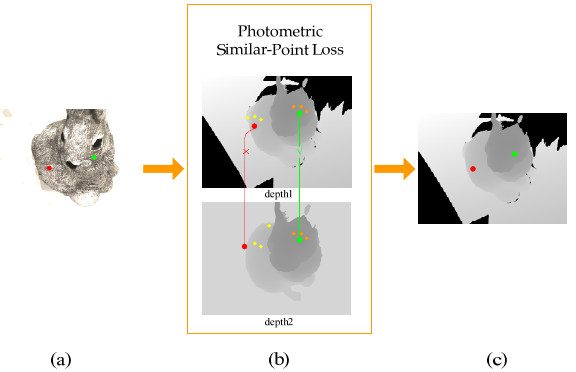
Figure 3. Photometric similar‑point loss: ( a ) a pirate point was selected on the source image; ( b ) the depth map obtained with the network was compared with the depth map constructed using sparse points; ( c ) optimized density depth map. The green line represents the success of the similarity match, and the red line represents failure of the similarity